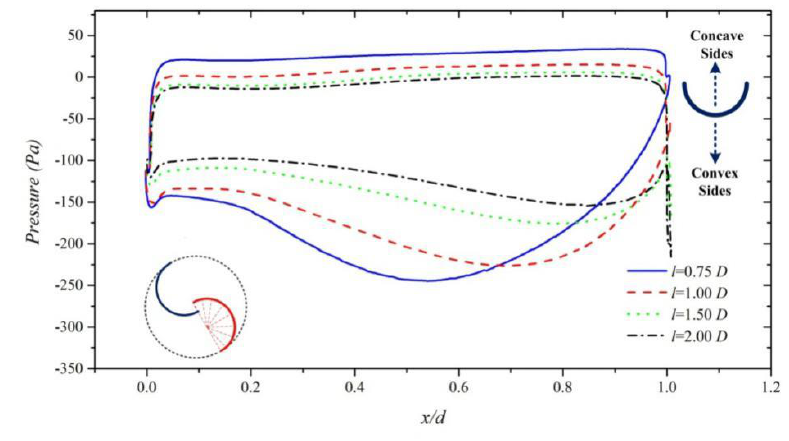
Figure 13. Pressure distribution on the blade at θ = 120° and at different installation positions.